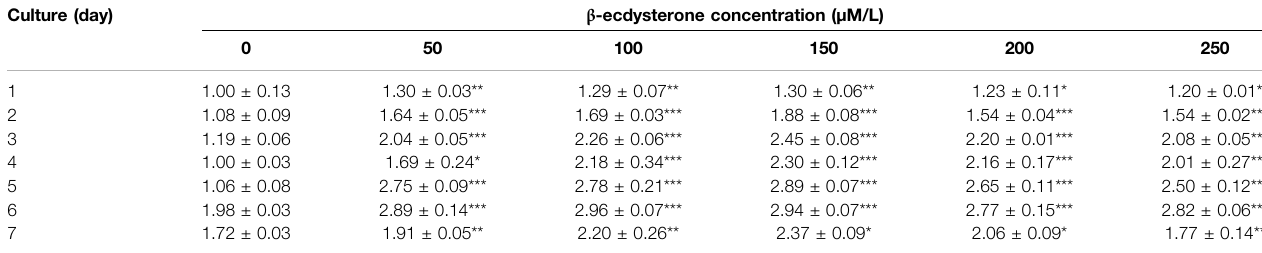
TABLE 2 | Effects of β -ecdysterone on the proliferation of MC3T3-E1 cells ( OD value , X ± SD ). Culture (day)